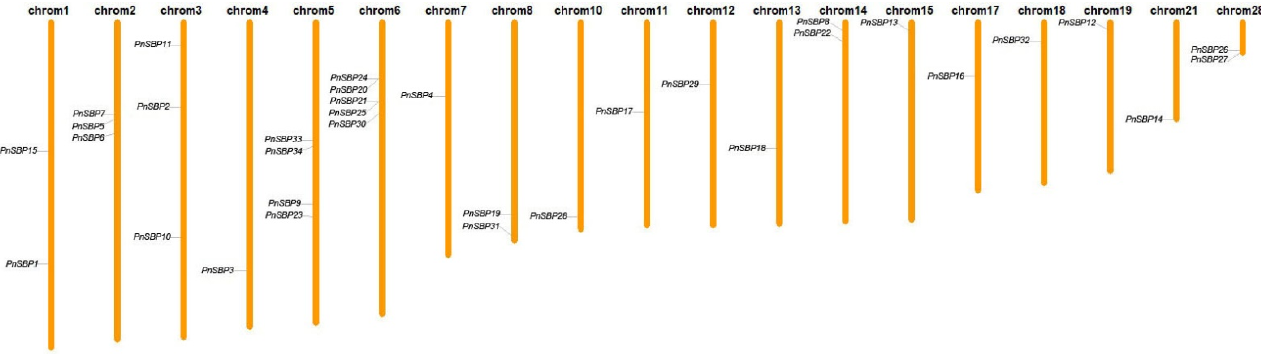
Figure 4. The gene distribution in the pepper genome.